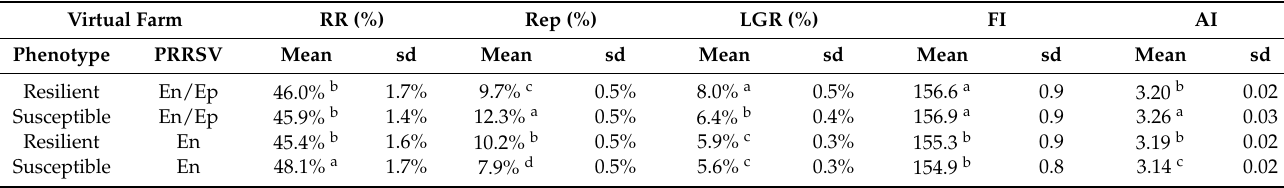
Table 8. Annual production parameters for each virtual farm by taking into account the phenotype of the sow (Resilient or Susceptible) and the porcine reproductive and respiratory syndrome (PRRSV) epidemiological scenario (Endemic versus Endemic and Epidemic). The epidemic phase corresponds to one PRRSV outbreak that lasted 24 weeks in duration within three